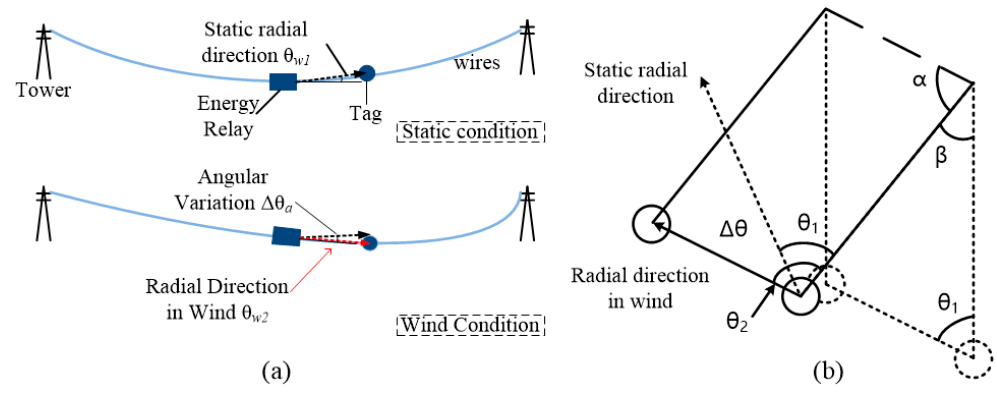
Figure 5. Wind influence on energy transmission: ( a ) Transmission on the same line; ( b ) Cross section of transmission on different lines.